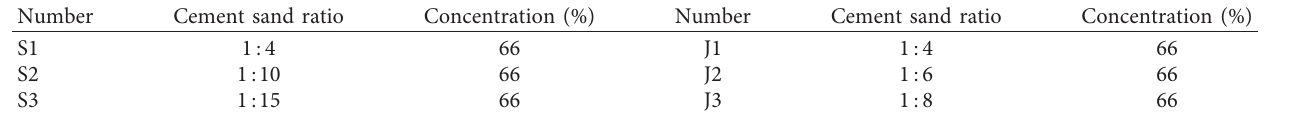
Table 1: Parameter design of reinforced backfill.